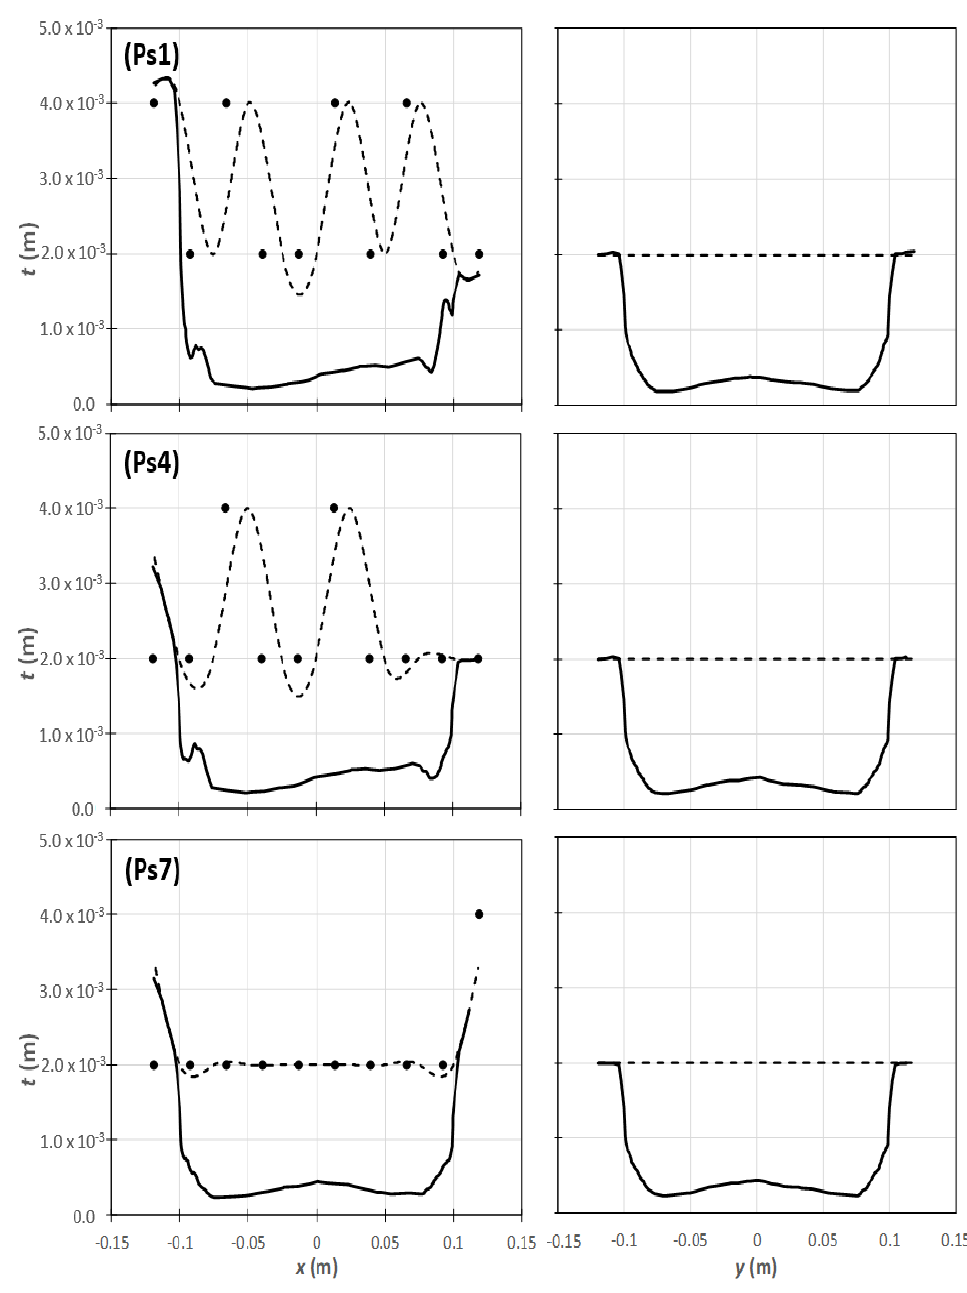
Figure 11. Thickness profile for solutions Ps1, Ps4 and Ps7 (Figure 9): left—black points are the decision variables, dashed line is the spline and the continuous line the part thickness profile a x = 0; right—sheet and part thickness profiles for x = 0.